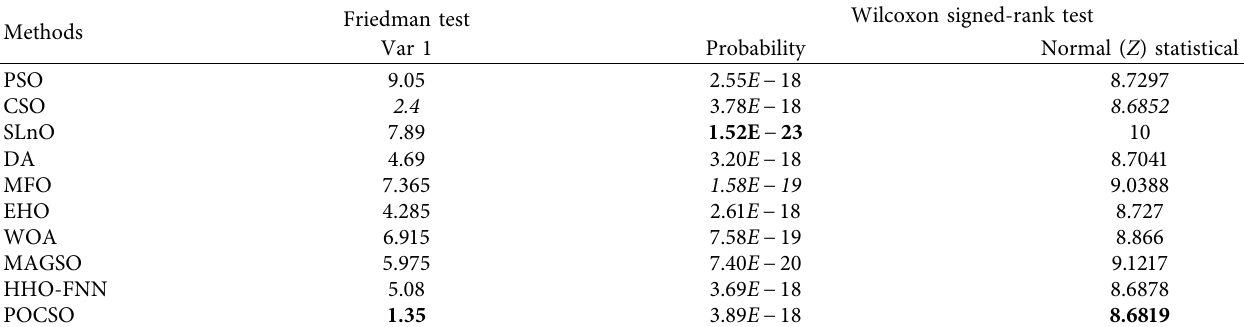
Table 12: Nonparametric statistical analysis for IEEE-14 bus